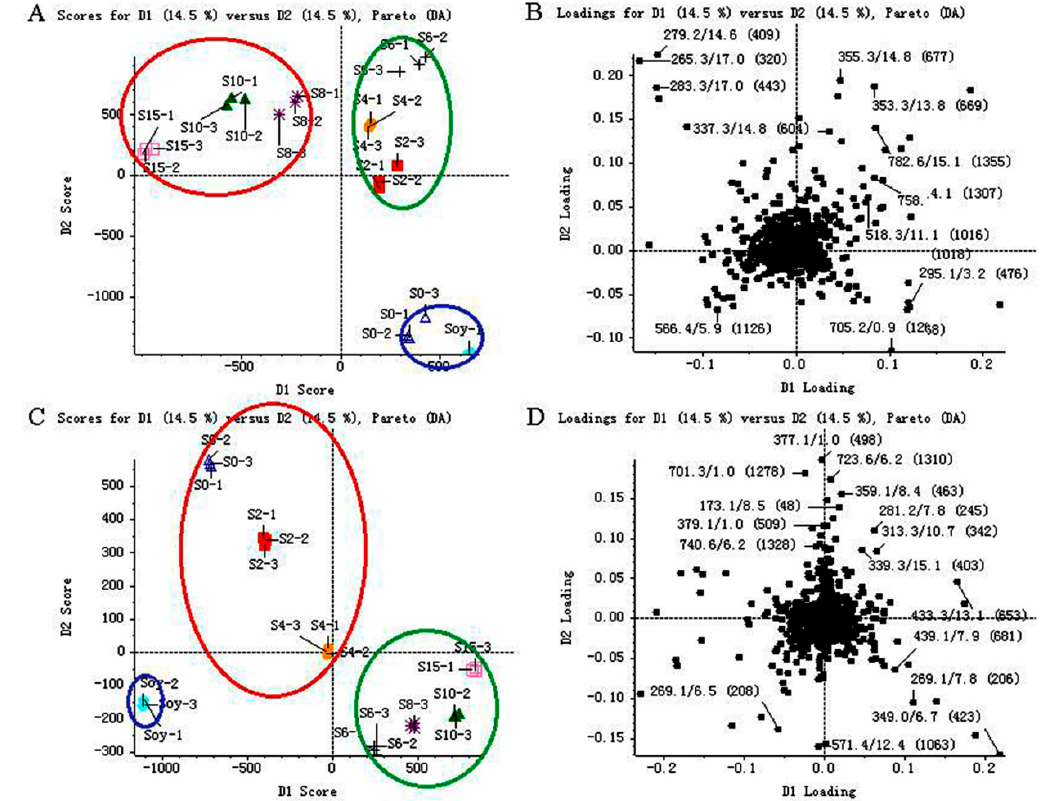
Figure 3. Score plots ( A , C ) and loading plots ( B , D ) of metabolites determined in soybean (Soy) and Sojae semen praeparatum products (S0, S2, S4, S6, S8, S10 and S15) by UFLC–TripleTOF MS in both positive (A and B) and negative (C and D) ion modes. The three clusters (green, blue and red) were used for the color coding of different groups separated by the first and second principal components.